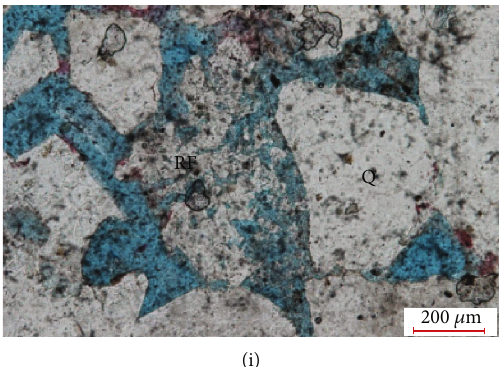
Figure 8: The diagenetic characteristics of E w in the southern Lufeng depression. (a) Debris particles are broken, and the edges of the 2 particles show weak quartz overgrowth, 3701 m, W6. (b) Intergranular pores are fi lled with quartz overgrowth and early calcite cement, 4170.98m, W4. (c) Intergranular pores are fi lled with early calcite cement, 4158.75m, W4. (d) Residual intergranular pores are fi lled with Fe-calcite and chlorite cements, 4060.3m, W7. (e) Residual intergranular pores are fi lled with Fe-calcite cement, the thin section also shows the intragranular dissolved pores in feldspar, 4190 m, W2. (f) The same characteristics of (e) in the orthogonal polarization, 4190m, W2. (g) Feldspar is dissolved to form the dissolved pores, and the kaolinite is fi lled into the intergranular pores, 3611.4m, W10. (h) The feldspar is completely dissolved, and the dissolved pores do not collapse. (i) The dissolution of the rock fragment, 3719.5 m, W6. Qo: quartz overgrowth; Fr: fracture; Ca: calcite; FC: Fe-calcite; Kf: K-feldspar; Kao: kaolinite; RF: rock feldspar; Ch: chlorite; PL: point- line contact; CC: concave-convex